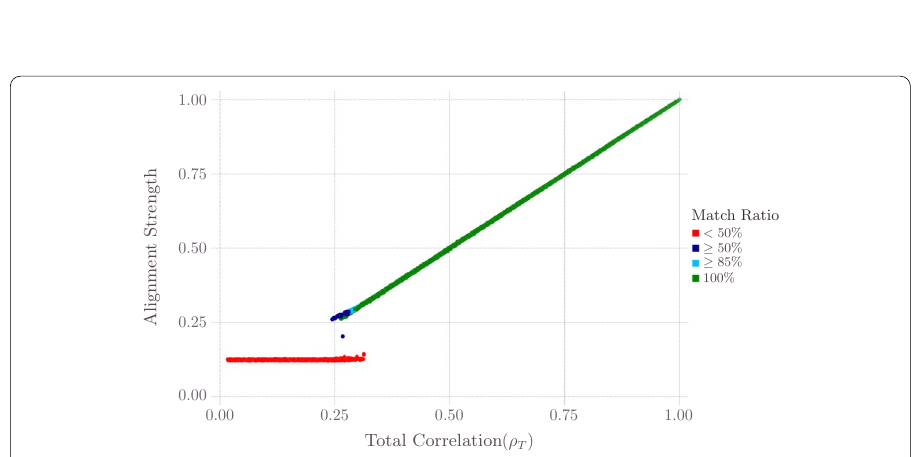
Fig. 6 Experiment C in Sect. “Block settings”; eight different combinations for F 1,1 , F 1,2 , F